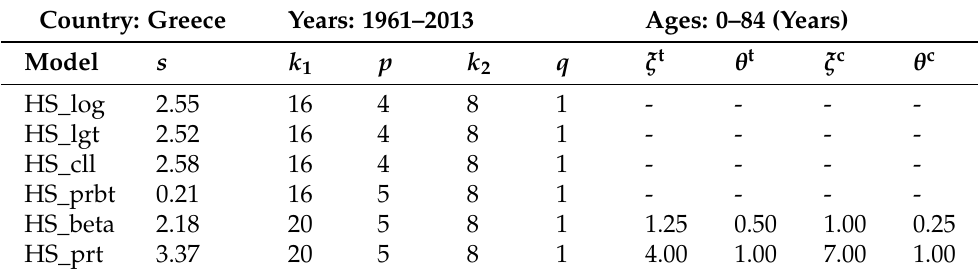
Table 3. Optimum parameters for each HS model extension structure for the GR dataset. Country: